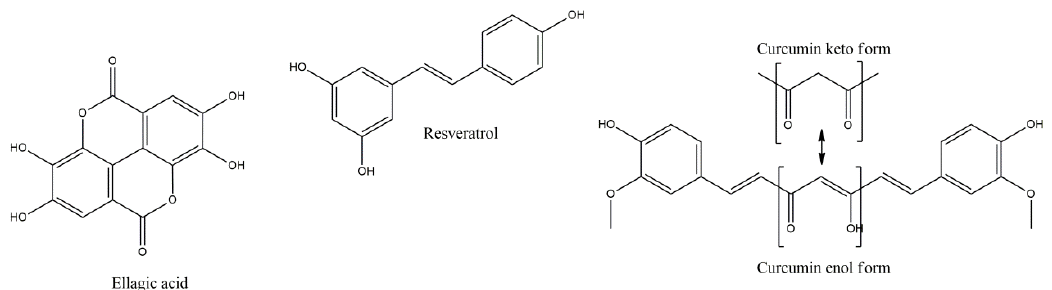
Figure 4. Ellagic acid, resveratrol and enol-keto form of